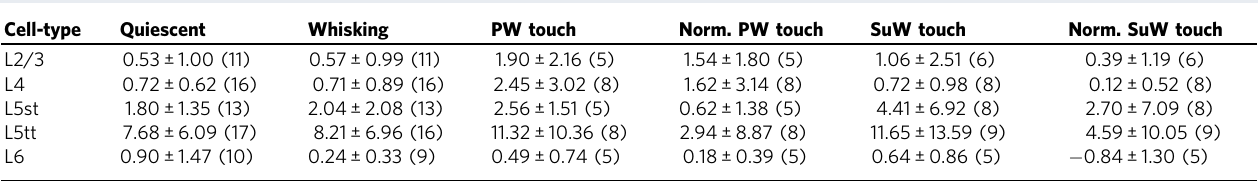
Fig. 2 Single-cell and population spiking upon naive object touch. a Representative morphologies of cell types across S1 layers. In L(ayer 4), data from pyramidal neurons and spiny stellates is pooled. In L6, data from corticocortical and corticothalamic neurons are pooled. In L5, slender-tufted (st) and thick-tufted (tt) pyramids represent distinct cell types. b Population PSTHs for fi ve major excitatory cell types triggered to onset of PW touch (PW) or surround whisker touch (SuW), normalized for the number of touch events for individual recordings. Bin size 5 ms, blue line indicates touch start, the gray line end of 0 – 100 ms touch start window, respectively. The L5st-SuW population PSTH was dominated by a single L5st. Colors distinguish cell types and match the color code in d . For PW/SuW: L2/3 n = 5/ n = 6, L4 n = 8/ n = 8, L5st = 5/ n = 8, L5tt n = 8/ n = 9, L6 n = 5/ n = 5. c Cell-type-speci fi c spiking activity (in Hz) during quiescence (top) and upon touch (below, corrected for spontaneous activity). For n-numbers PW/SuW: analogous to data in Fig. 2b. d AP budget for 0 – 100 ms windows across behavioral states (quiescent, whisking, and touch) and PW touch versus SuW touch. Gray shading is normalized to the cell-type-speci fi c maximal number of APs within a behavioral condition. Table 1 State-dependent spiking